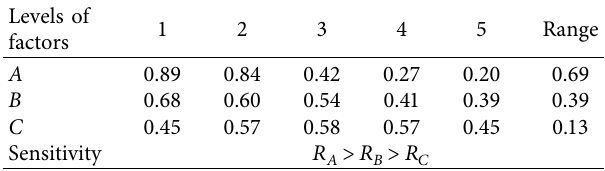
Table 11: Sensitivity analysis of tensile strength to three factors. Levels of factors